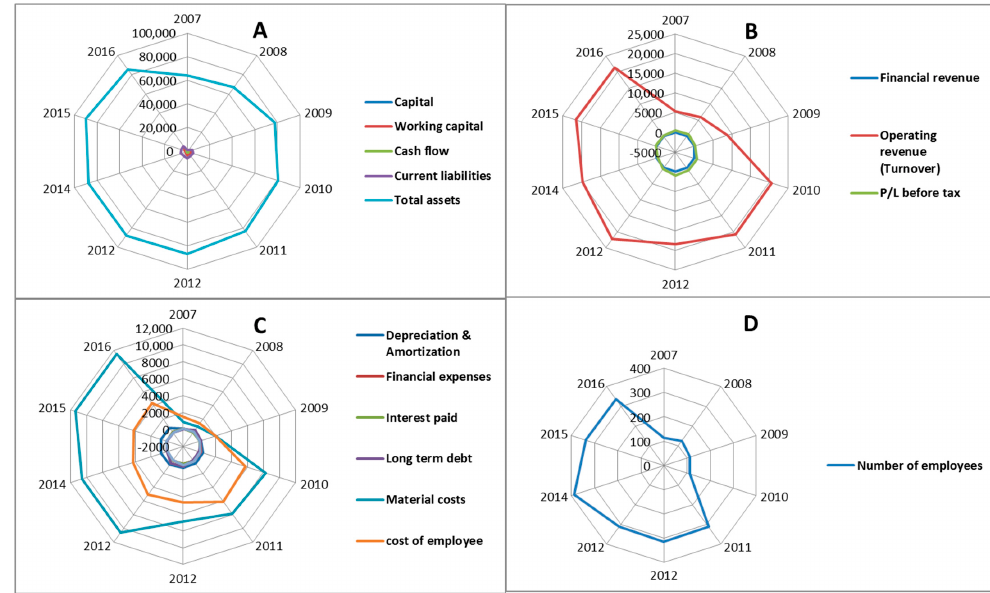
Figure A3. Historical financial results of the companies: Transport segment of the coal value chain. ( A )—financial performance; ( B )—result of the activity; ( C )—costs; ( D )—employment. The companies operating in the Transport segment of the value chain show a different trend compared to the previous two segments. Here, the performance of the sector seems to be constant during the last 5–7 years. Again, the completeness of the data collected for the four groups of variables seem to be nonhomogeneous, as some variables (i.e., working capital) record very low levels all through the time horizon of the analysis.